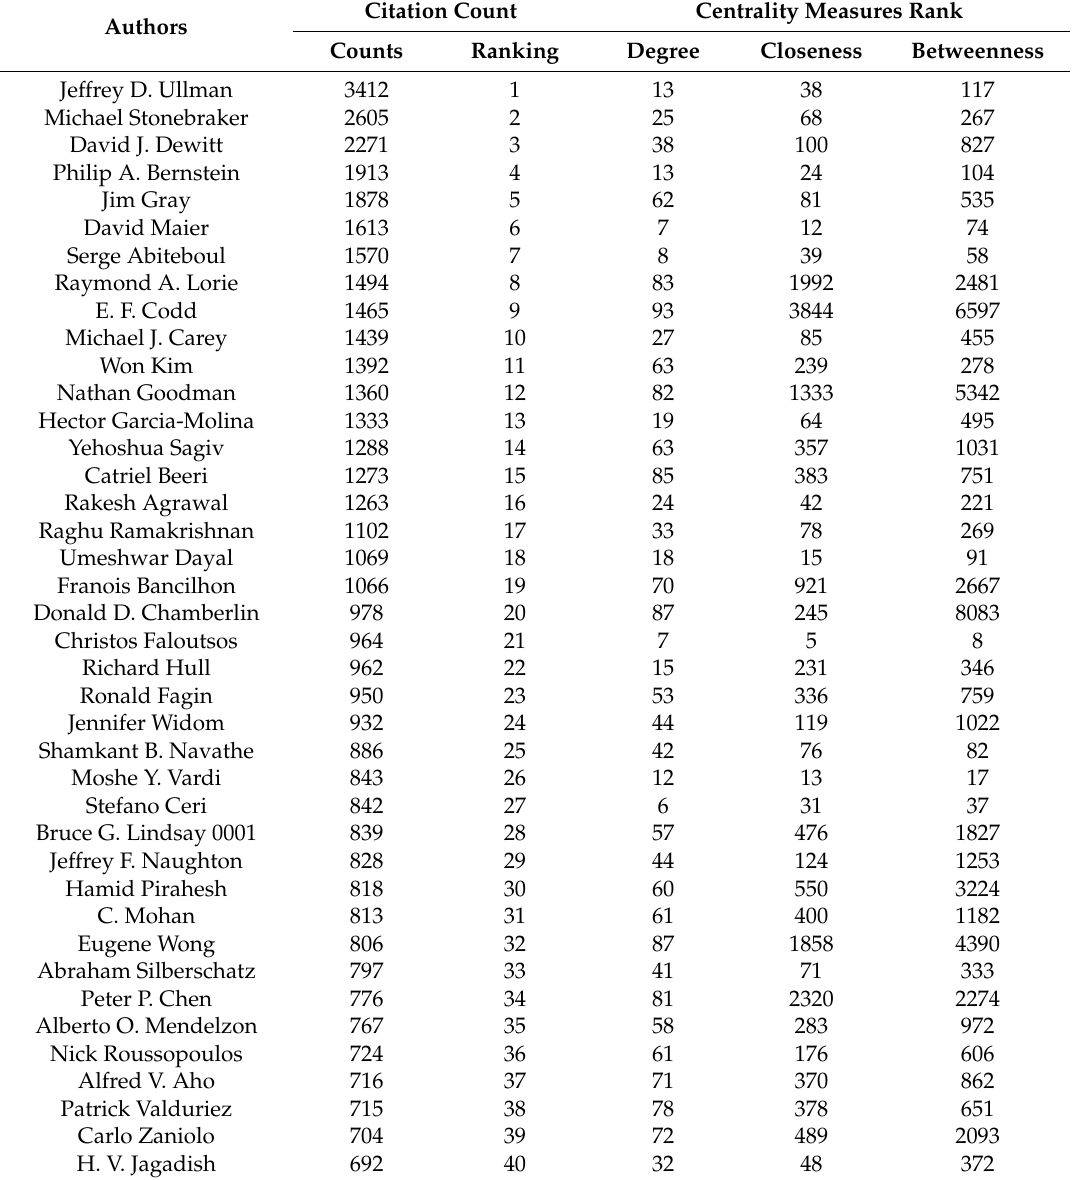
Table 4. Top 40 authors based on the citation